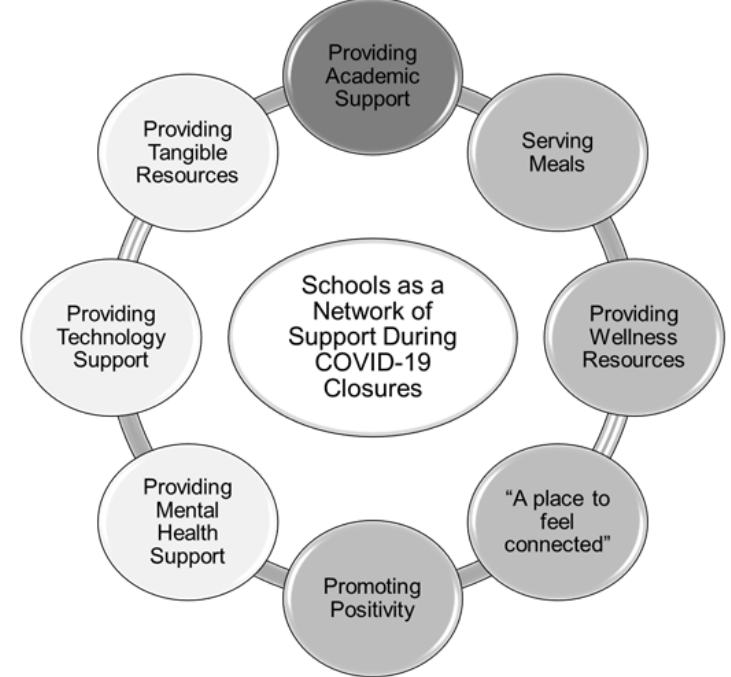
Figure 1. Components of schools’ network of support . Note. Bubbles with darker shading reflect a higher frequency of mentions by participants.